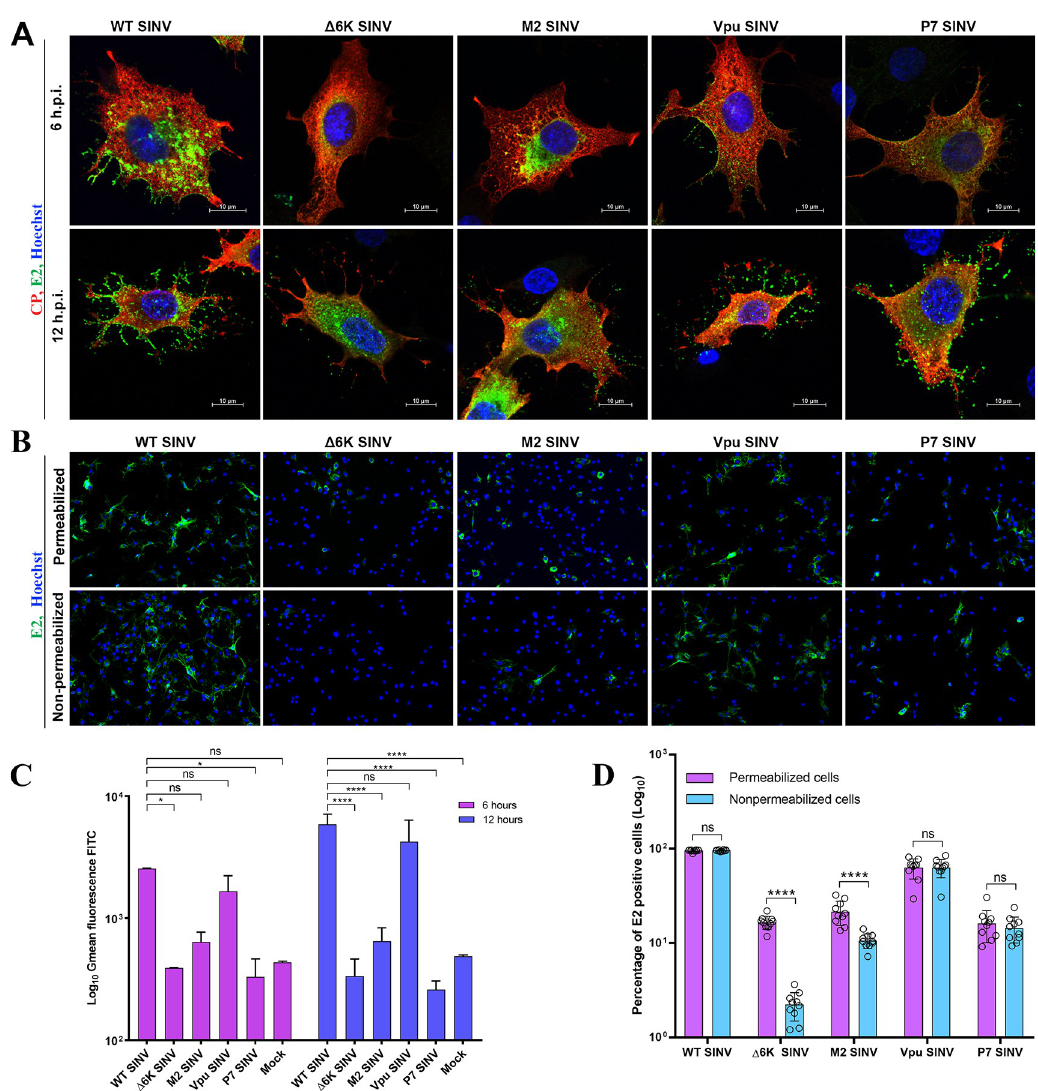
Fig 2. Functional complementation of 6K by other viral ion channels. (A) IF analysis of permeabilized BHK-15 cells infected with WT SINV, Δ 6K SINV, M2 SINV, Vpu SINV, or P7 SINV at 6 or 12 hpi using antibodies against E2 (Green) and CP (Red). (B) IF analysis of glycoprotein trafficking to the plasma membrane under permeabilized or non-permeabilized conditions. BHK- 15 cells were electroporated with RNA corresponding to WT or 6K mutant viruses and fixed at 12 h post-electroporation Anti-E2 monoclonal antibody was used to detect glycoproteins. Nuclei were stained with Hoechst stain. (C) Flow cytometry analysis of cells infected with WT or 6K mutant viruses at an MOI of 5. Cells were incubated with a monoclonal anti-E2 antibody followed by staining with FITC secondary antibody. Results are shown as a log 10 of the geometric mean of the region of the curve measuring the amount of E2 fluorescence at the plasma membrane. Data shown are from two independent experiments. Error bars indicate standard error of mean (SEM). Significance was determined using Dunnett’s multiple comparisons test as part of two-way ANOVA with a 95% confidence interval. p Values were considered significant when p < 0.05 ( � ), p < 0.01 ( �� ), p < 0.001( ��� ), and p < 0.0001( ���� ). ns indicates “not significant”. (D) Quantification of glycoprotein trafficking to the plasma membrane from (B). The number of cells expressing E2 (green) relative to the total number of cells (blue) was determined using the NIS Elements software. Cells from 10 independent frames per condition were counted. Error bars indicate standard error of mean (SEM). Significance was determined by multiple unpaired t-tests of data. p Values were considered significant when p < 0.05 ( � ), p < 0.01 ( �� ), p < 0.001( ��� ), and p < 0.0001( ���� ). ns indicates “not significant”.